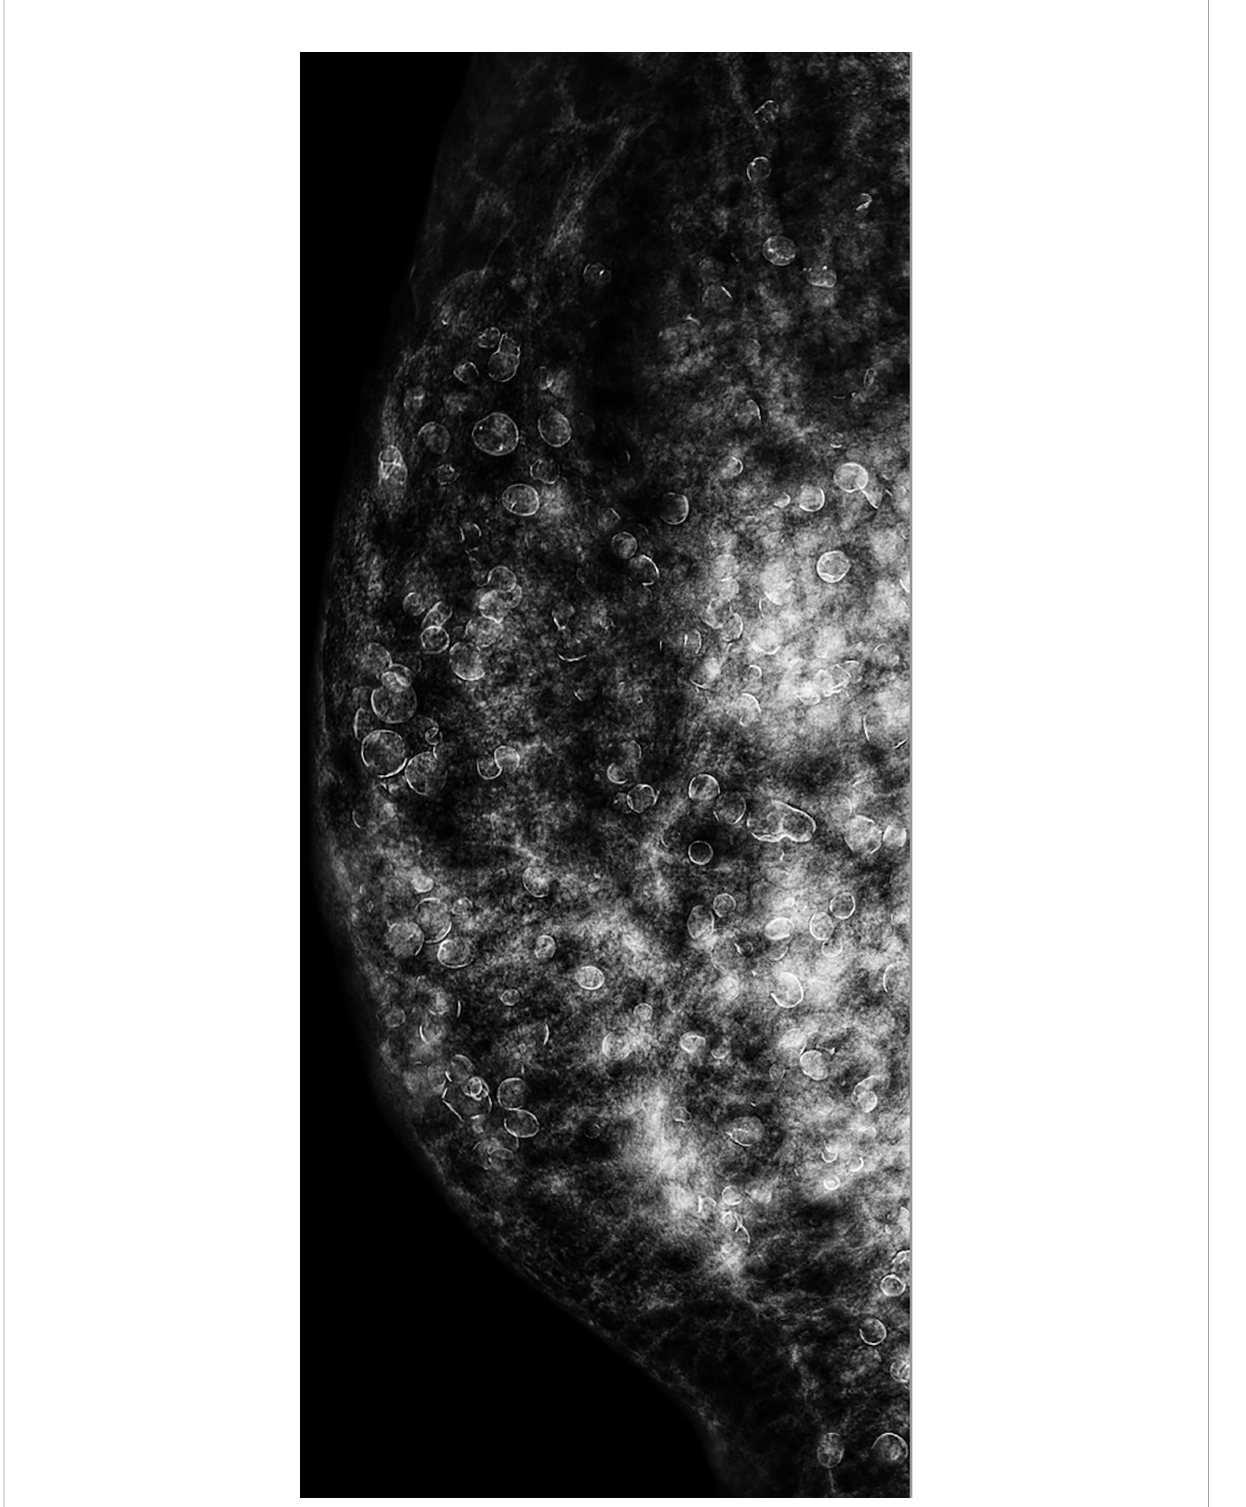
FIGURE 2 CESM (LM in lateral view) of the right breast showed inhomogeneous dense breast and numerous droplets of injected silicone with rim calci fi cations. The masses on CE-MRI were not observed. CESM, contrast-enhanced spectral mammography; LM, low-energy mammogram; CE-MRI, contrast-enhanced magnetic resonance